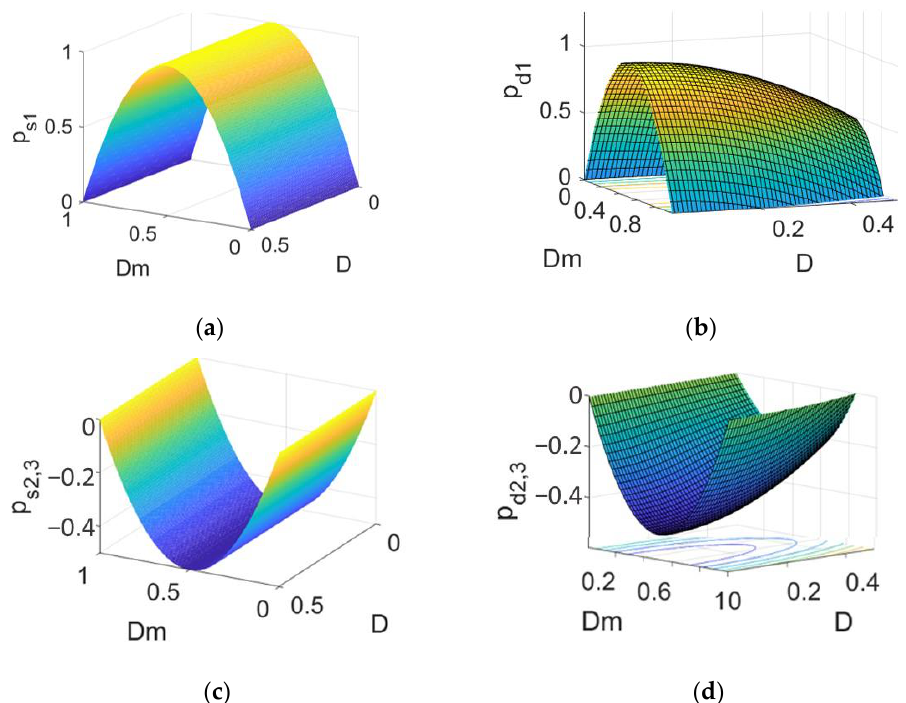
Figure 8. Characteristic of the power at the different ports for the SPS and the DPS ( a ) at port one for SPS, ( b ) at port one for DPS, ( c ) at ports 2 and 3 for SPS, and ( d ) at ports 2 and 3 for DPS.